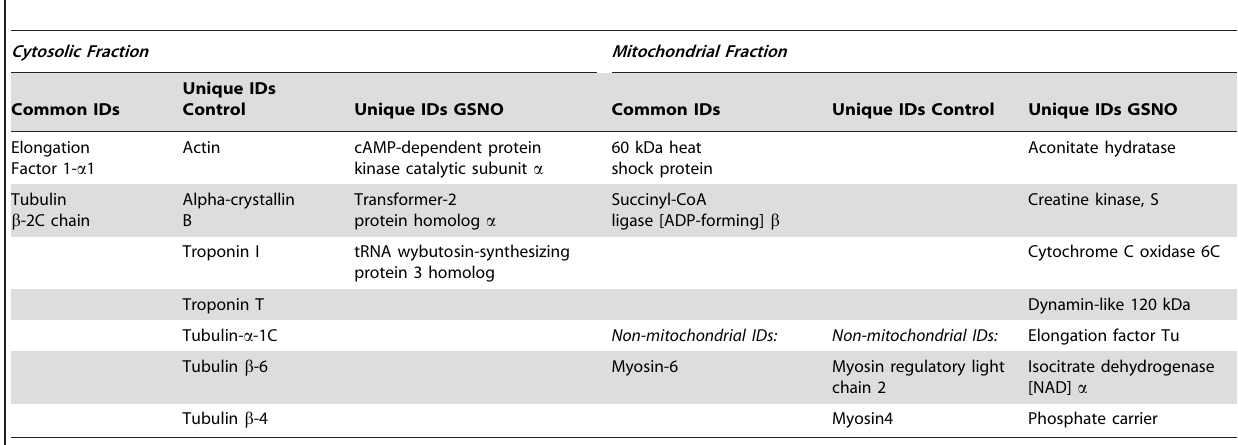
Table 1. GAPDH binding partners in cytosolic and mitochondrial fractions of hearts subjected to control or GSNO perfusion.